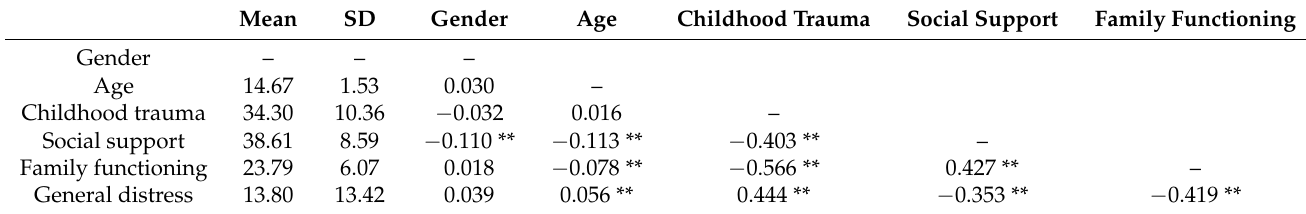
Table 2. Descriptive and correlation analysis.